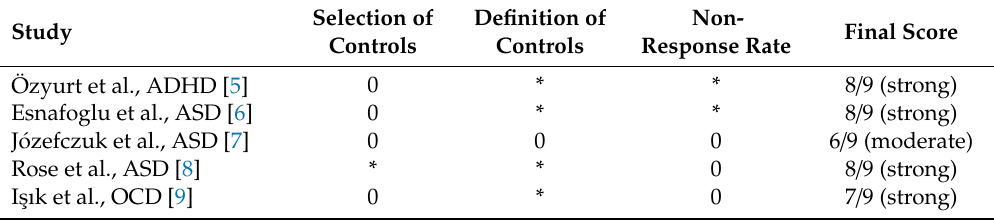
Table 6. Quality assessment of the included case-control studies by the N.O.S. scale. Selection of